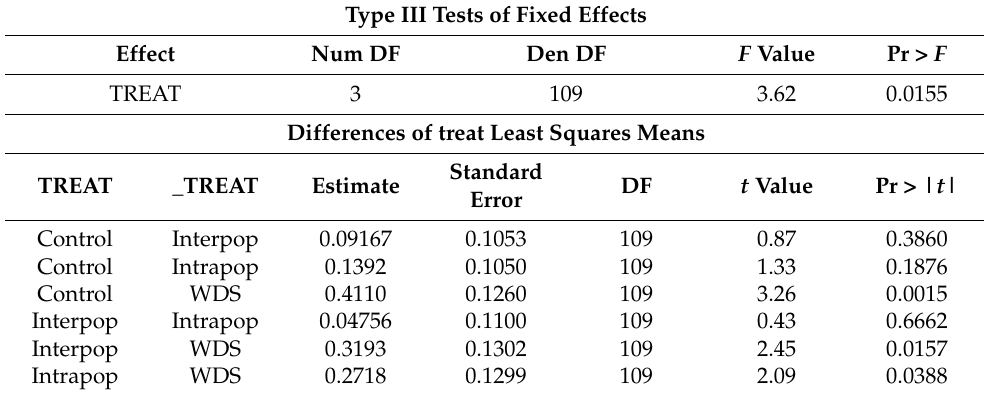
Table A5. Fertilization Success (fertilized ovules/total ovules).